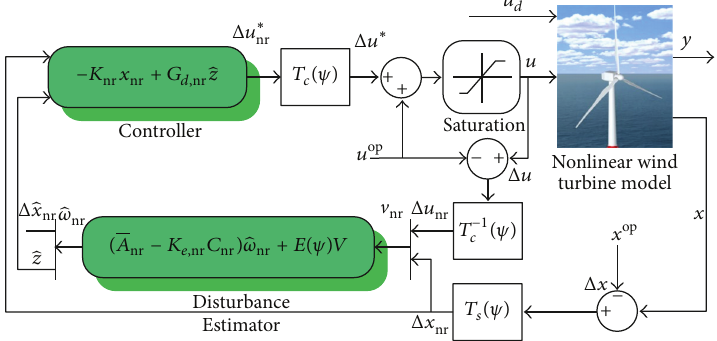
Figure 1: DAC implemented for